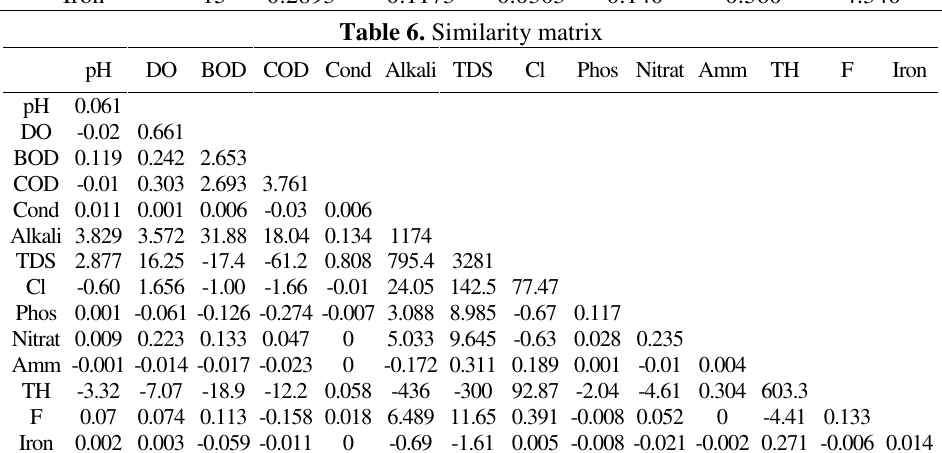
Table 6. Similarity